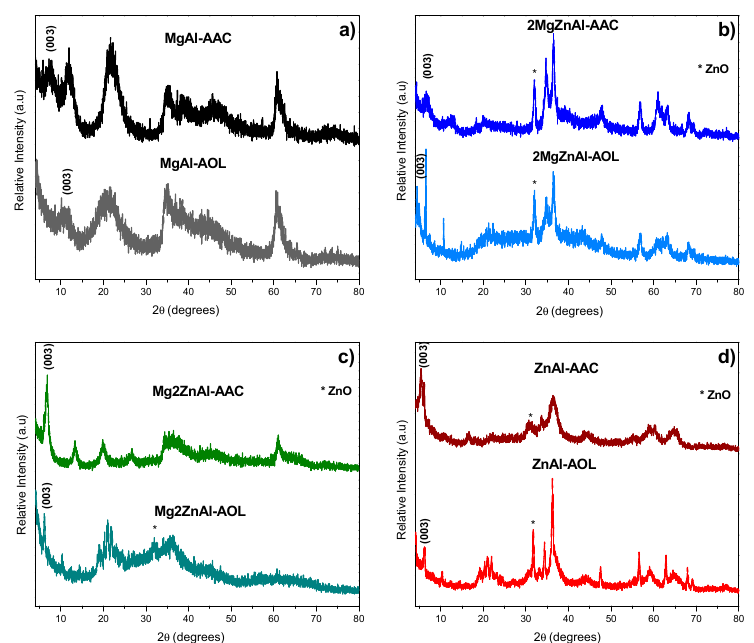
Figure 3. X-ray di ff raction patterns of LDHs modified with acrylate (ACC) and oleate (AOL) for: Figure 3. X-ray diffraction patterns of LDHs modified with acrylate (ACC) and oleate (AOL) for: ( a ) ( a ) MgAl, ( b ) 2MgZnAl, ( c ) Mg2ZnAl, and ( d ) ZnAl. MgAl, ( b ) 2MgZnAl, ( c ) Mg2ZnAl, and ( d ) ZnAl.